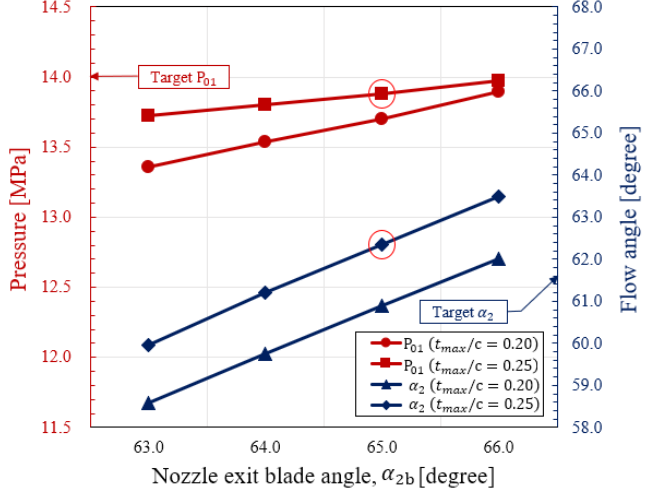
Figure 13. Pressure ( 𝑃 01 ) and flow angle ( 𝛼 2 ) according to the second-stage nozzle optimization of the radial outflow turbine.